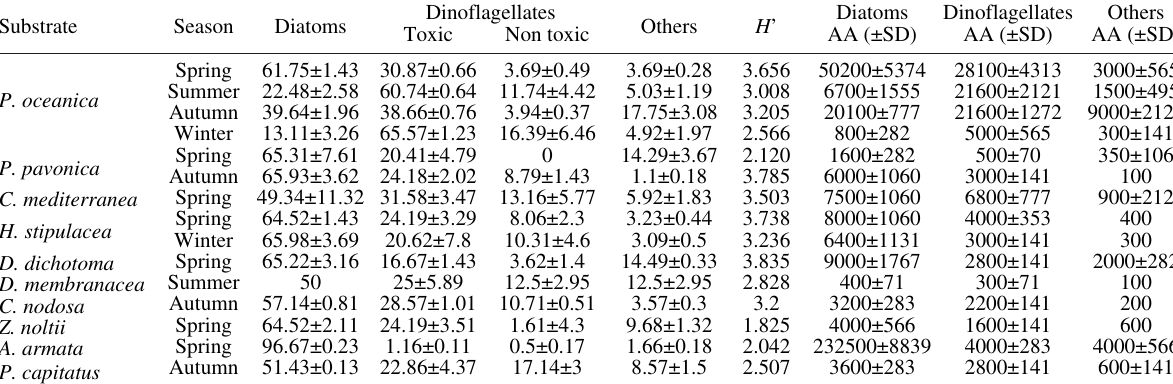
Table 3. – Absolute abundance and seasonal percentages (%) of abundance of different phytoplankton groups (relative to the total of epiphyte microalgae) sampled on various substrates. AA, absolute abundance (cells g –1 FW); SD, standard deviation; H ’, diversity index.